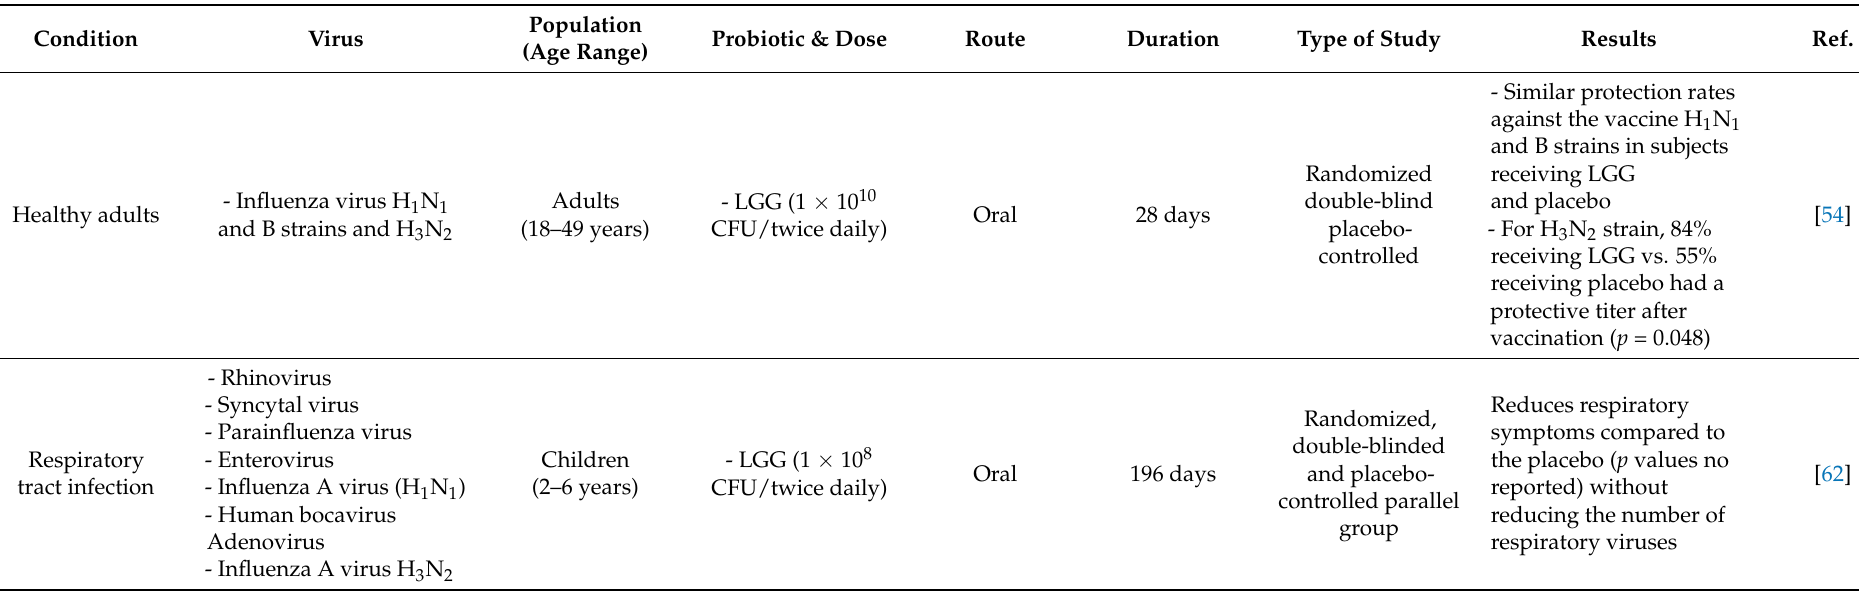
Table 1. Probiotics used in clinical trials of respiratory tract infections caused by